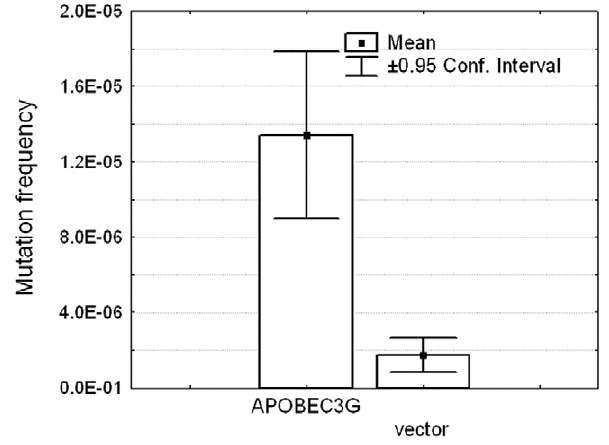
Figure 1. A3G is mutagenic in yeast. The frequency of 5-FOA- resistant colonies induced in the LAN-200 yeast strain carrying an A3G expression plasmid or vector alone is shown. One-way ANOVA F-test=29.99, p =0.00002.